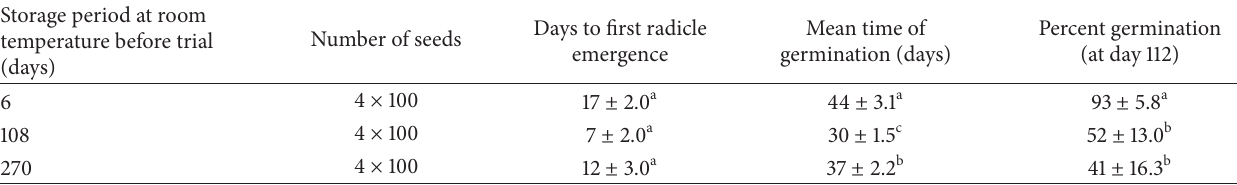
Table 3: The effect of storage period at room temperature on the germination characteristics of Calluna vulgaris seeds under a photoperiod of 8 h and a temperature regime of 10 ∘ C. Mean values ± standard deviations. In each column, groups that showed significant differences ( 𝑃 < 0.05 ) are indicated with different letters.